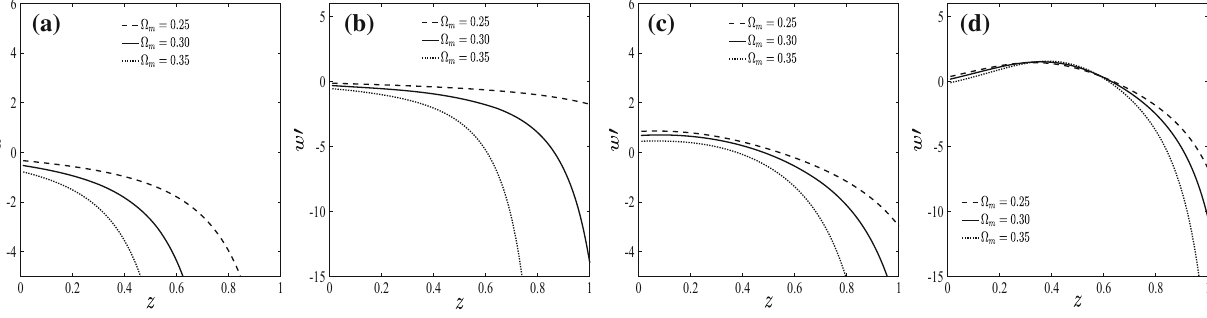
Fig. 10 Derivative of dark energy EoS d w/ d z for different cosmographic orders with varying parameter (cid:7) m from 0.25 to